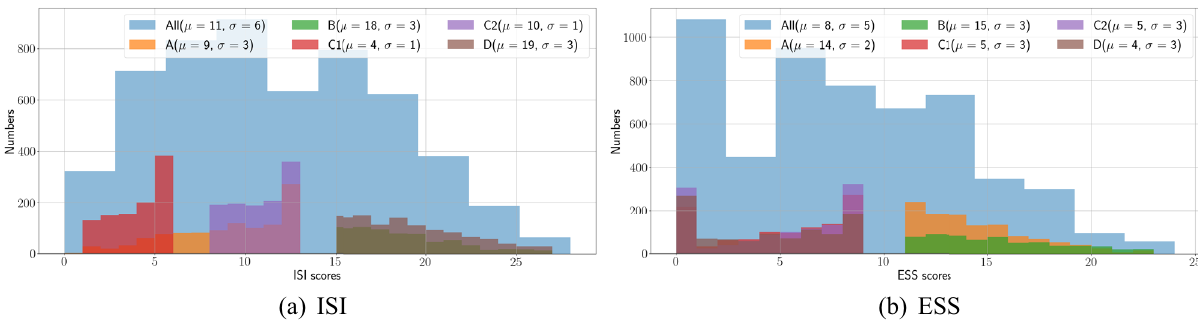
Figure 4. Histograms for each group, ISI and